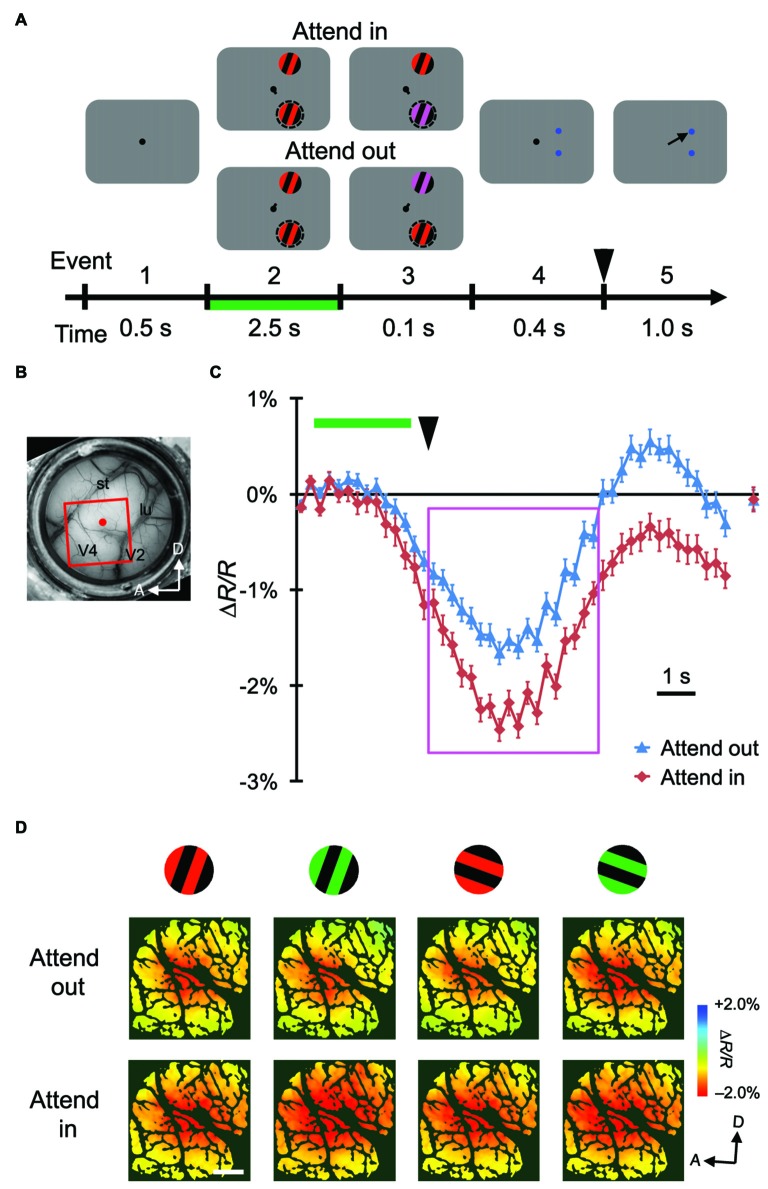
Stimulus-evoked hemodynamic responses in another monkey. (A,B) Sequence of the attention task and a view of the cortical surface of monkey M2. The side of imaged hemisphere was opposite to that of M1, and the task sequence and stimuli used were also slightly different. See “Materials and Methods” Section for details. (C,D) Time courses and maps of average stimulus-evoked reflectance changes in the imaged region of M2. To make the maps in (D), we averaged the signals from 3 s–7.5 s after stimulus onset, as indicated by the magenta rectangle in (C), on a pixel-by-pixel basis. Conventions are the same as Figure 1.